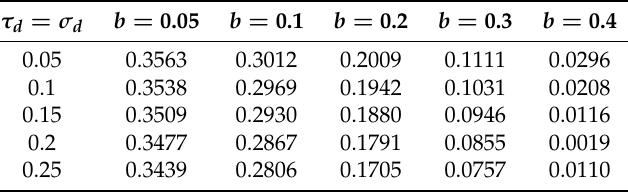
Table 4. Maximum allowable upper bounds α of Example